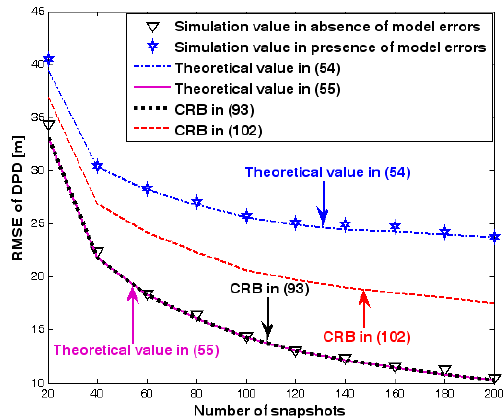
Figure 12. RMSE of DPD as a function of number of snapshots.